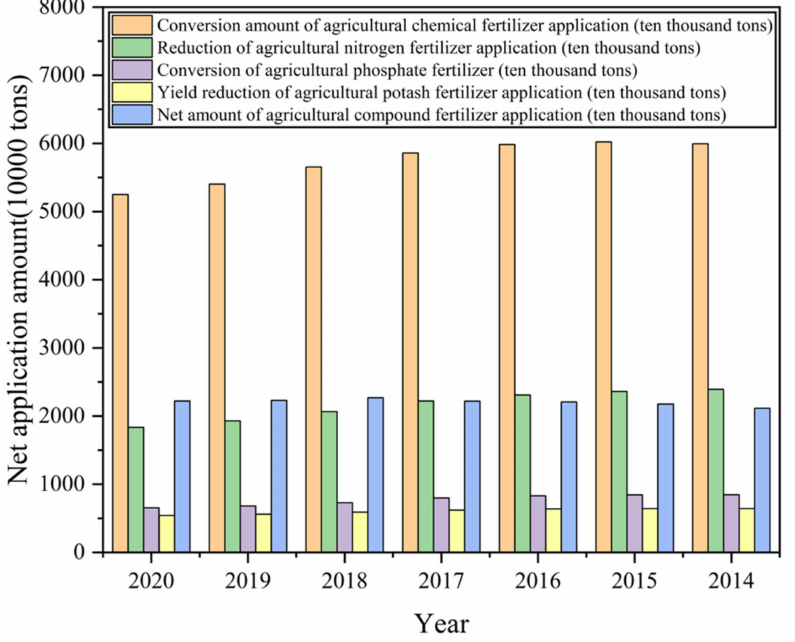
Figure 5. Chart of fertilizer use in China